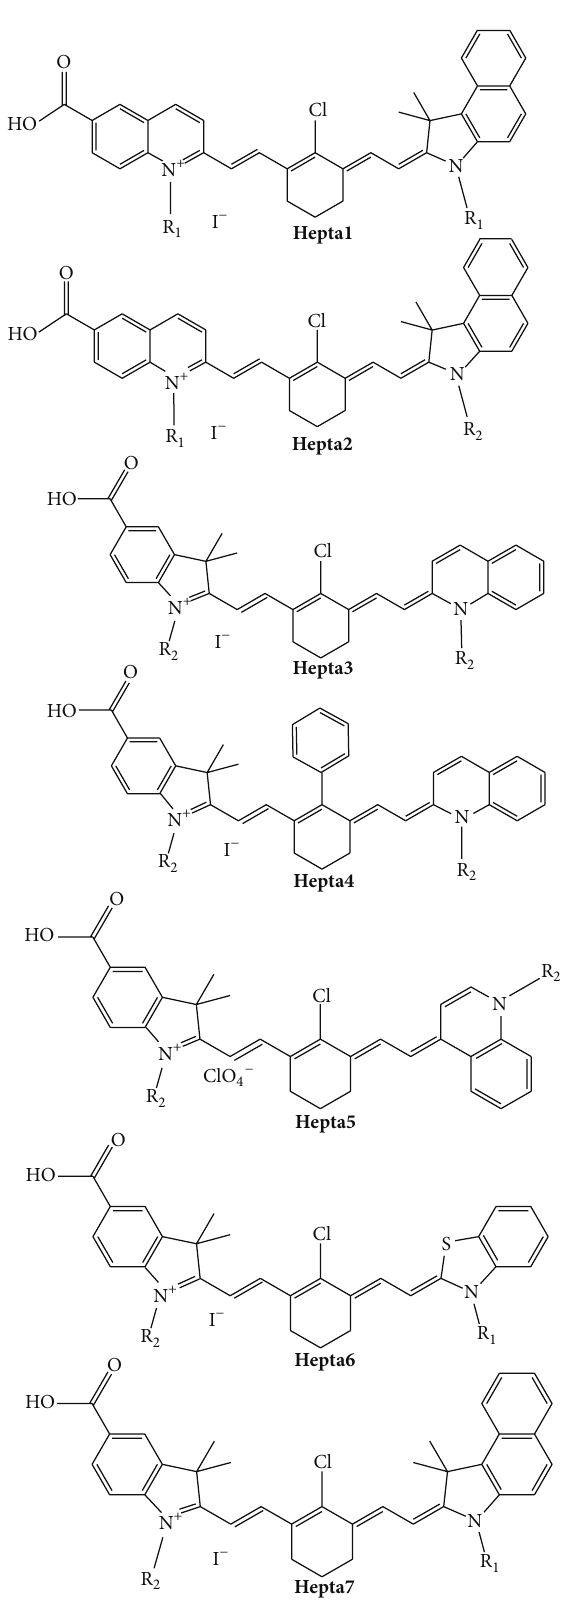
Figure 1: Synthesized unsymmetrical heptamethine dyes with one carboxylic acid anchor group. R 1 = ethyl, R 2 =